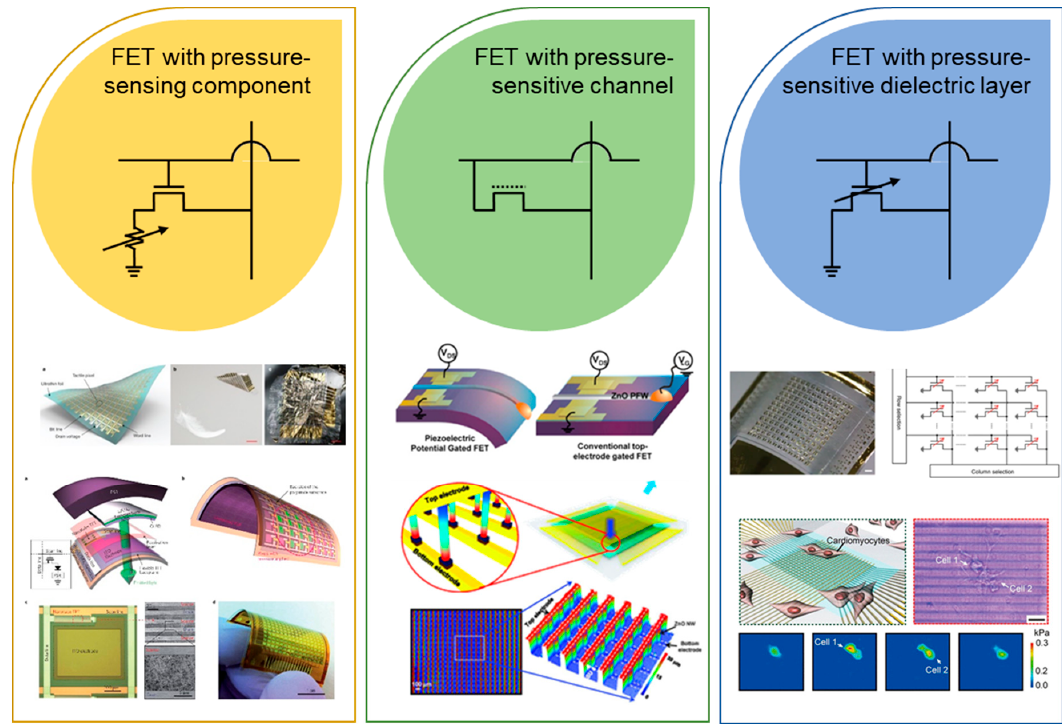
Figure 3. Representative tactile sensor arrays with active-matrix driving with circuits. Reproduced